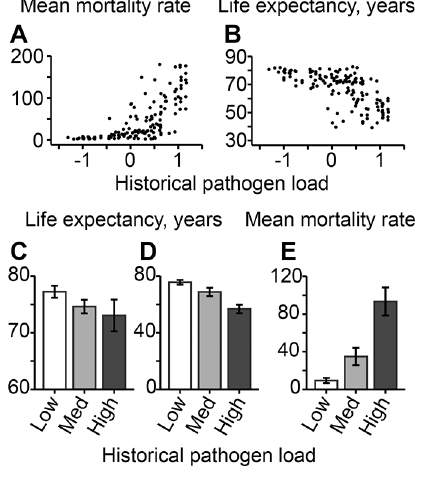
figure 3. Longer life expectancy in countries with lower historical pathogen load. (A) Mean mortality rate under 5 years (per 1,000 live births) and (B) life expectancy (data from http://data.worldbank.org/)